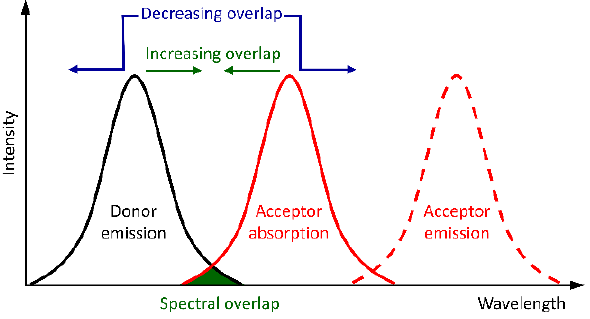
Figure 4. FRET activation and deactivation via electrochemically adjusting the spectral overlap integral for EFC use.